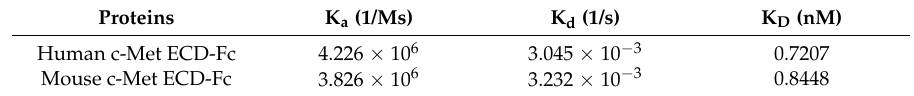
Table 1. Kinetic constants and binding affinities of IRCR201.